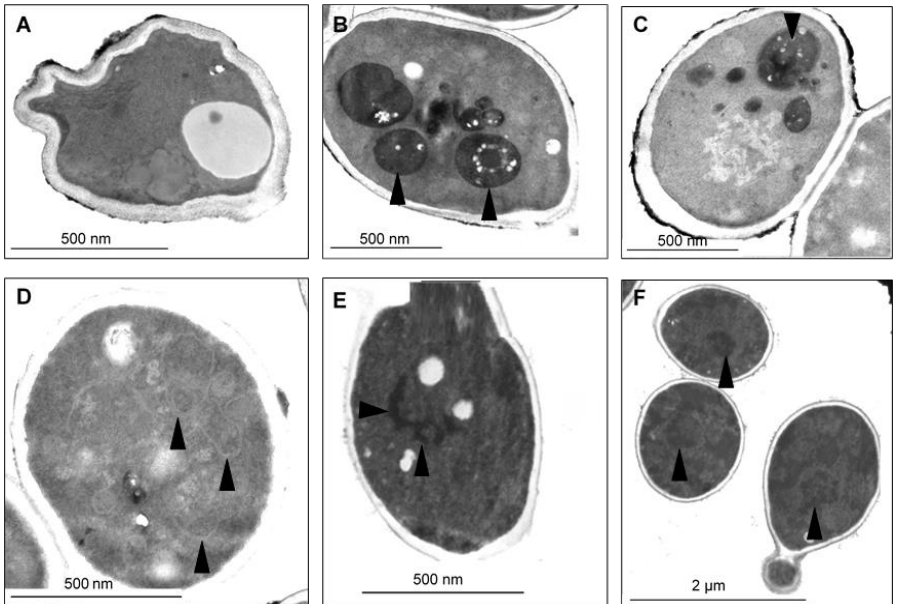
Figure 7. TEM micrographs of C. albicans SZMC 1423 treated with a sub-lethal concentration of CAPE exhibit different markers of cellular deterioration. ( A ) Severe cell wall distortion. ( B, C ) Appearance of enlarged lysosomes was rather frequently detected (arrowheads). ( D ) Isolation membranes precondition of cytoplasm fragmentation (arrowheads). ( E, F ) Nucleus fragmentation and marginal condensation (arrowheads).